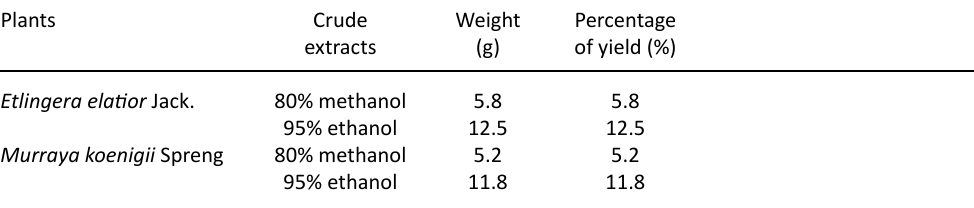
Table 2. Zone of inhibition of C. albicans by the plant extracts Species Plant part Crude extract Zone of inhibition (mm) Etlingera elatior